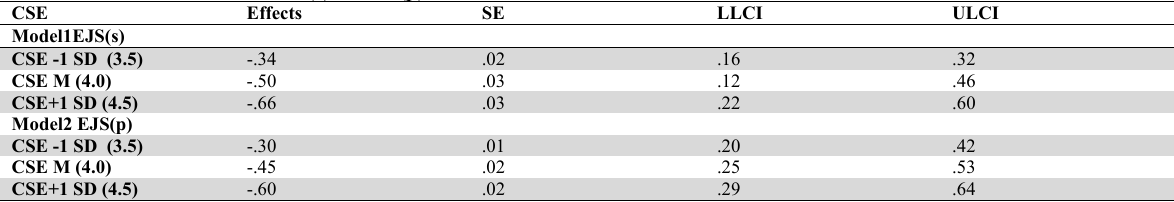
Conditional direct effects of EJS(s) &EJS (p) on TOI at the value of moderator CSE Effects LLCI CSE -1 SD